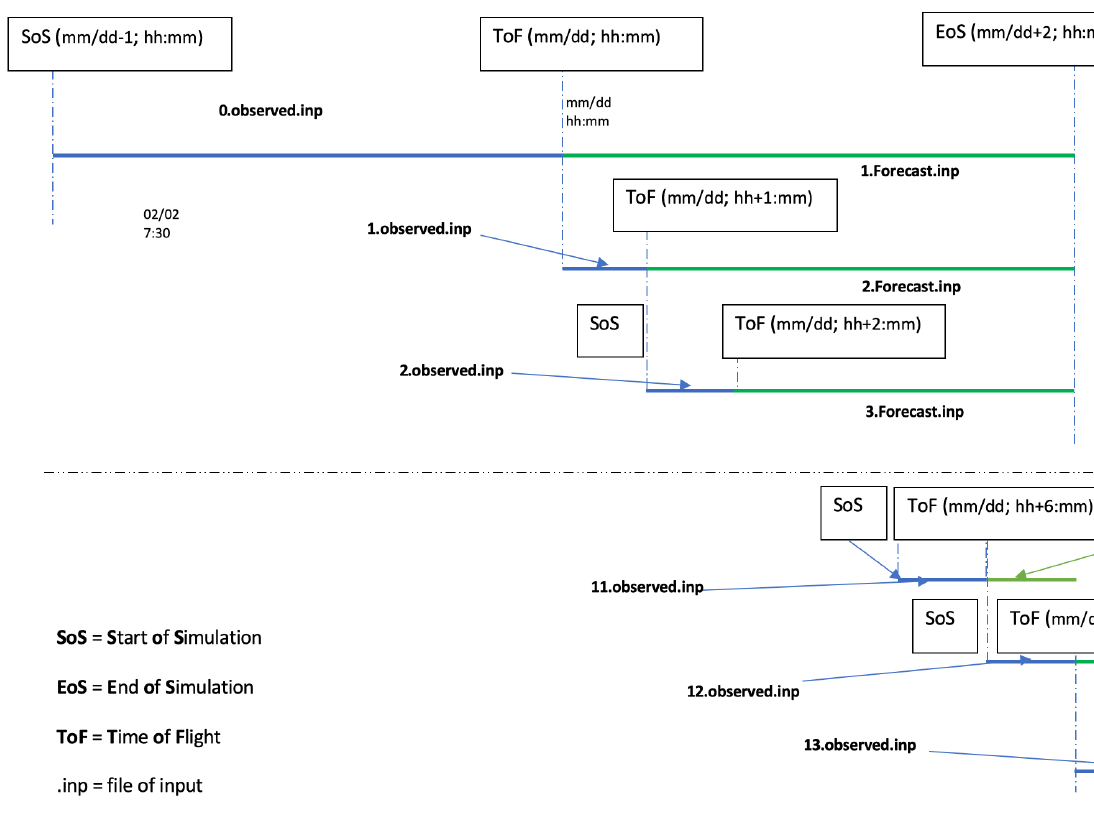
Figure 12. Sequences of run of SWMM software, in an “on-line” early warning